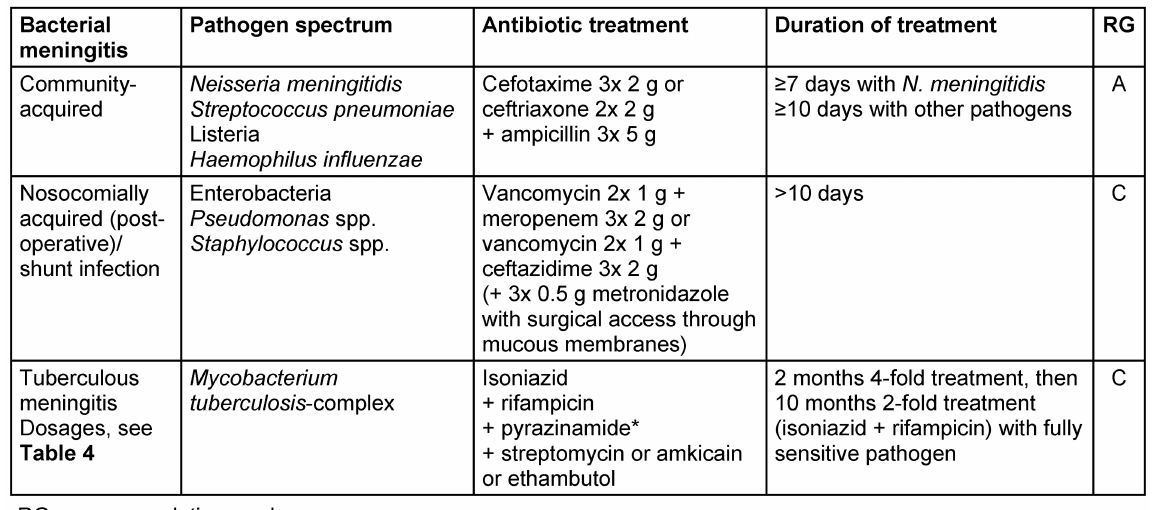
Table 1: Calculated antibiotic treatment of bacterial meningitis in adults. The recommendations of the S2k guideline on the treatment of tuberculosis by the German Central Committee for the Control of Tuberculosis e.V. on behalf of the German Society of Pneumology and Respiratory Medicine